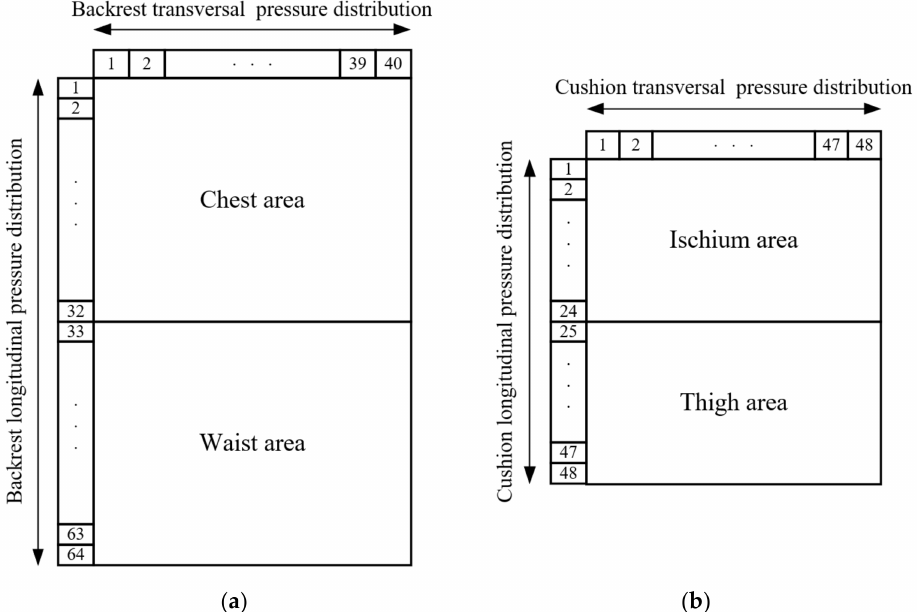
Figure 7. ( a ) Seat backrest transversal and longitudinal pressure distribution; ( b ) Seat cushion transversal and longitudinal pressure